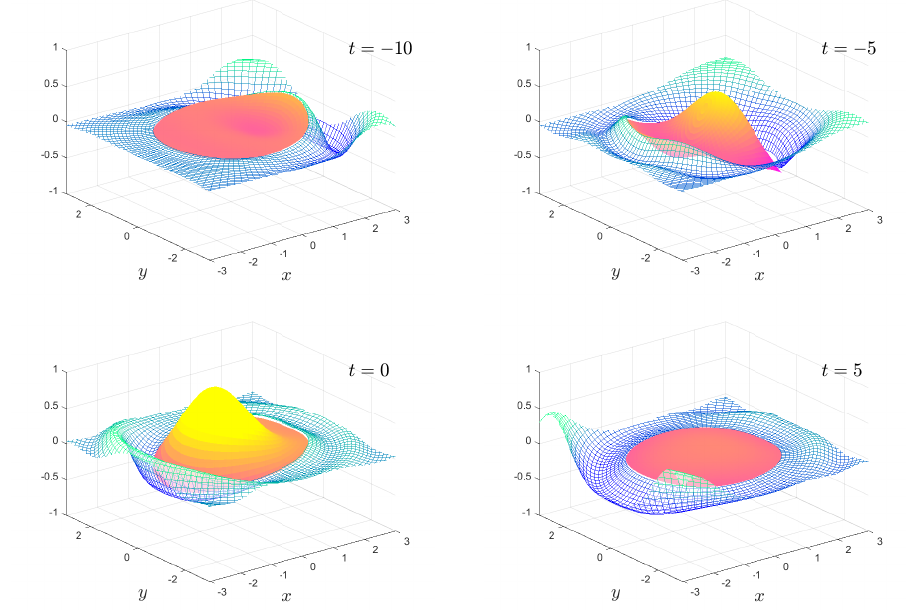
Figure 8. As in Figure 6, except β = 1 × 10 − 4 . The full animation can be found in movie